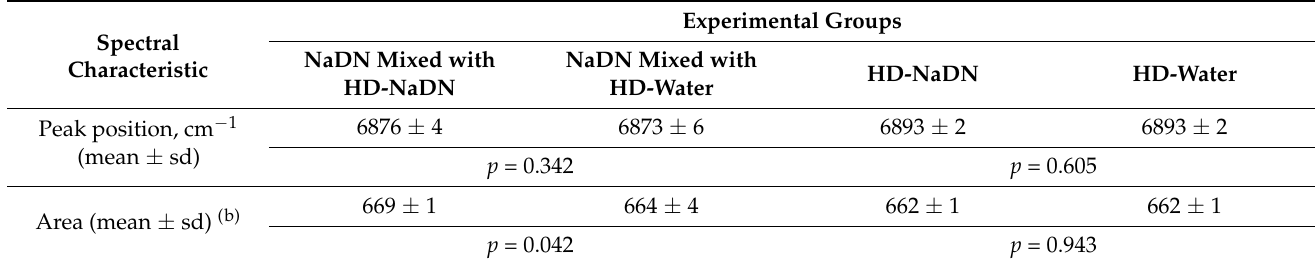
Figure 8. ( a ) Difference spectrum of “NaDN mixed with HD-NaDN”—“NaDN mixed with HD- water”. ( b ) Difference spectrum of “HD-NaDN”—“HD-water”. Table 1. Characteristics of the adjusted spectra of four solutions (experimental groups). The result of comparison of groups ( p -value) according to the characteristics shown in the table is indicated (a)